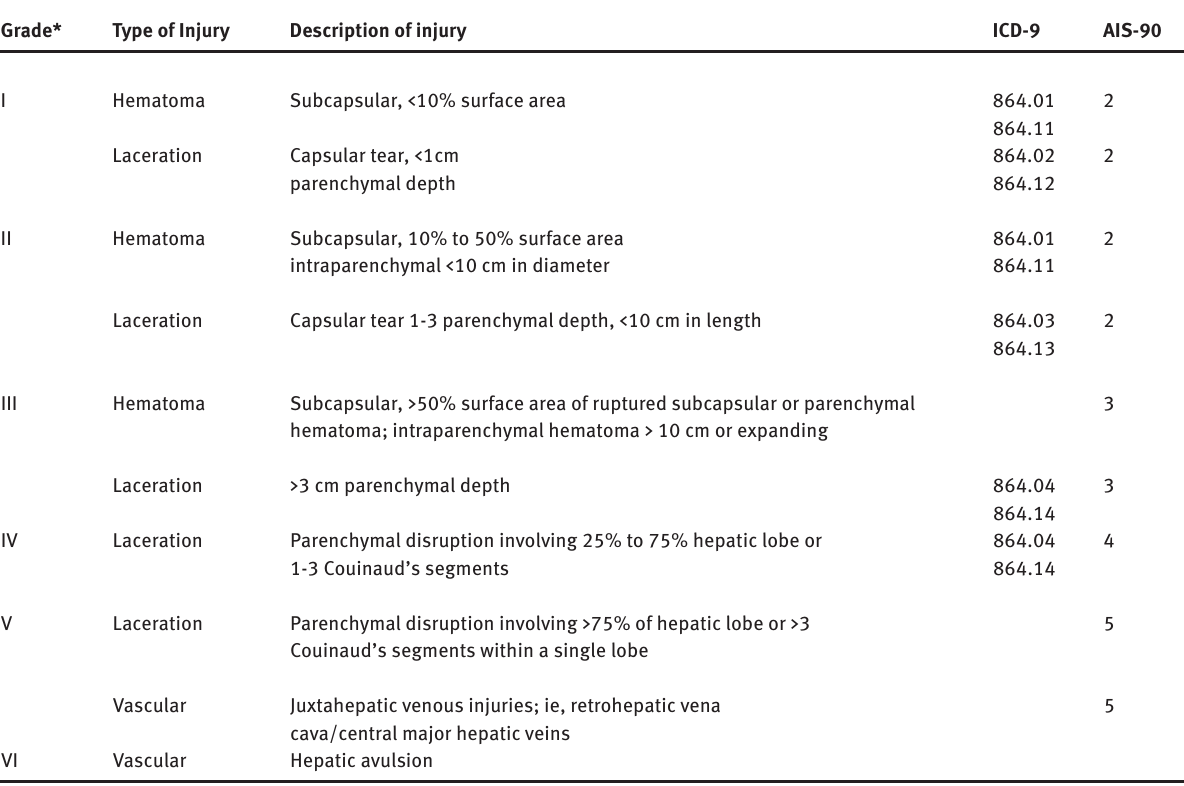
Table 1 : AAST – HEPATIC INJURY SCALE Classification of liver trauma following the American Association for the Surgery of Trauma (AAST) and the Organ Injury Scale Committee (1989)